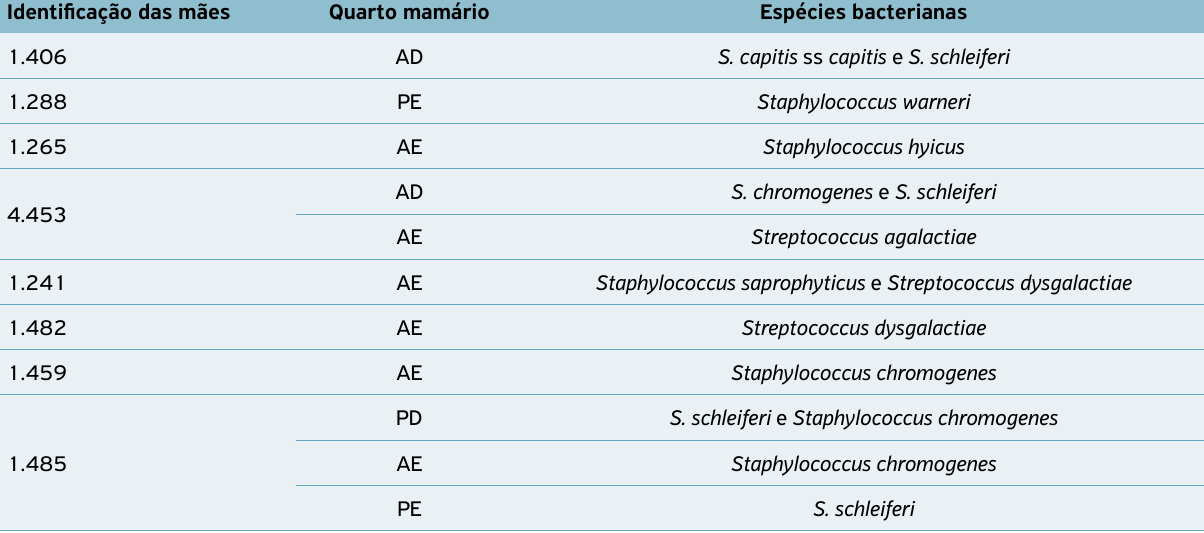
Tabela 1. Espécies bacterianas isoladas do colostro bovino de vacas holandesas no